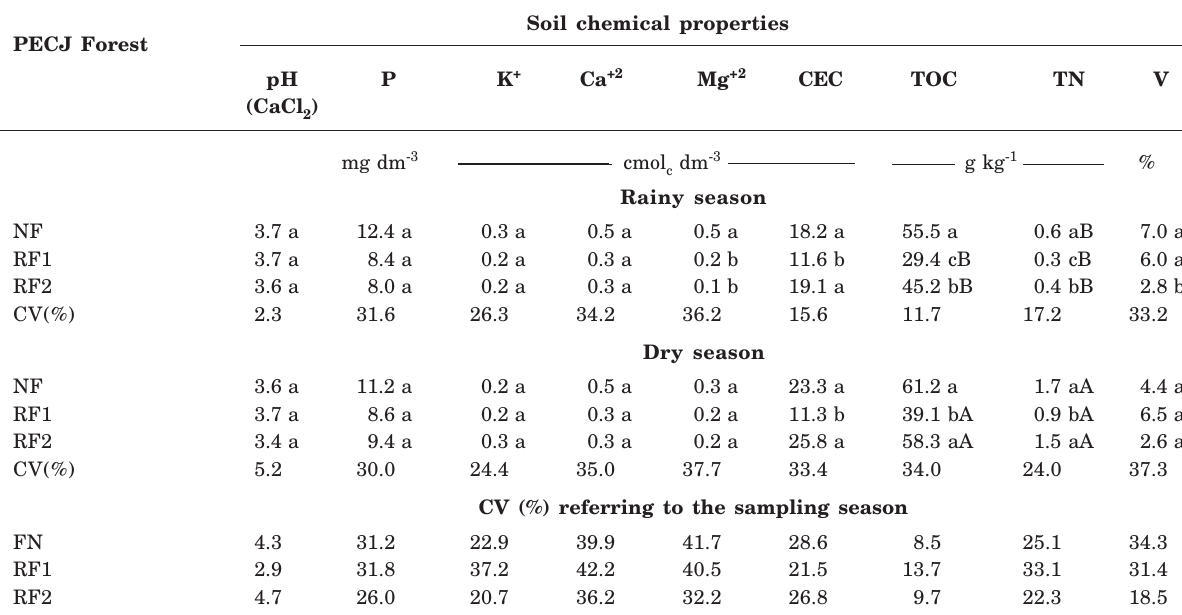
(NF: natural forest; RF: replanted